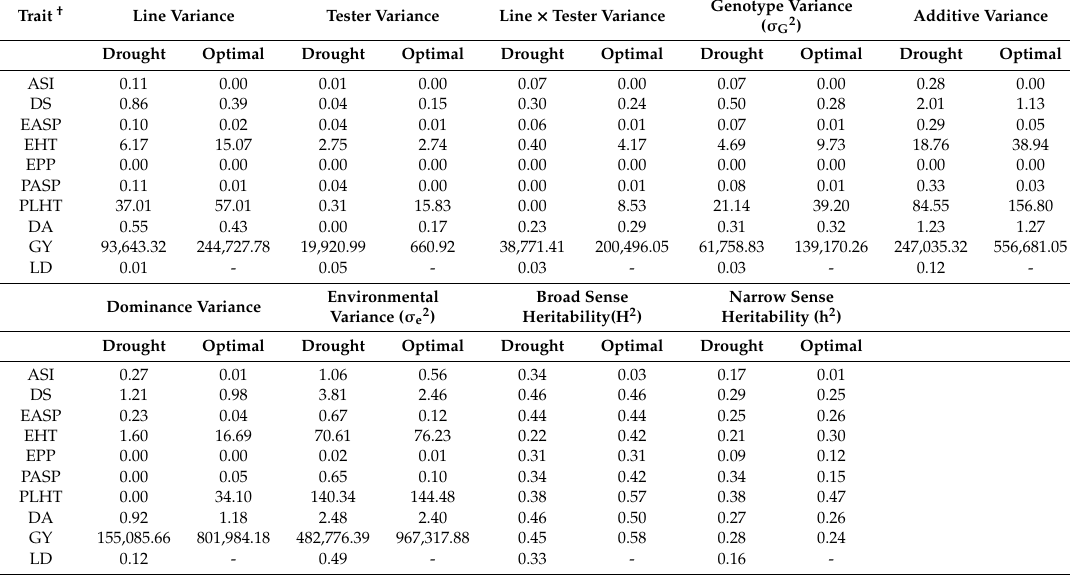
Table 4. Estimates of variance components, heritability and genetic gains under drought (2013 and 2014 seasons at Ikenne) and optimal (2014 cropping season at Ikenne and